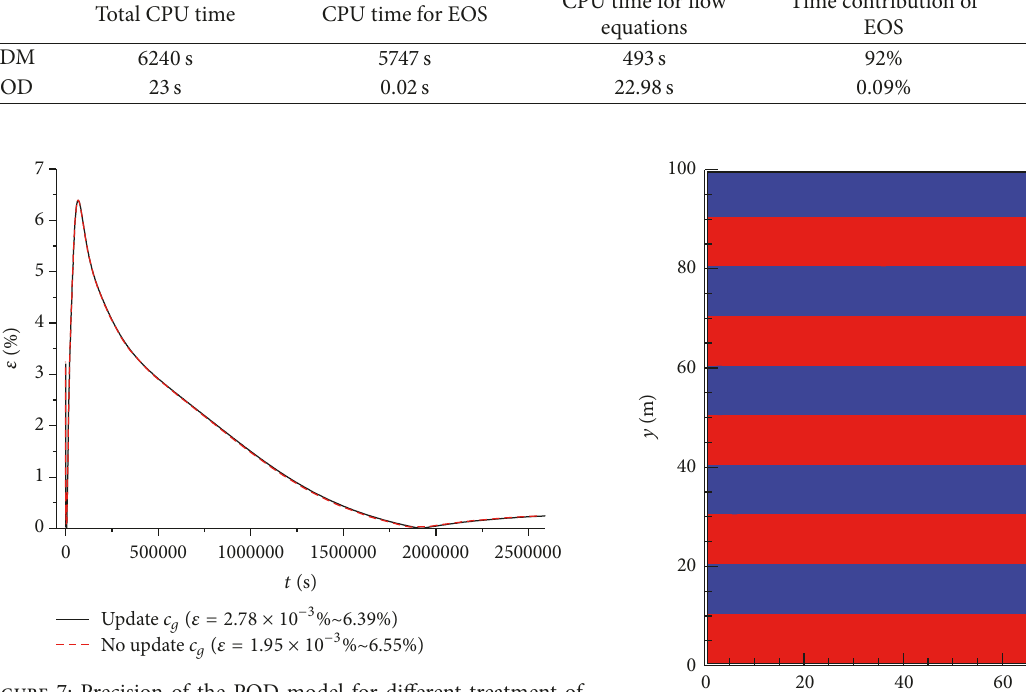
Figure 7: Precision of the POD model for different treatment of compressibility.